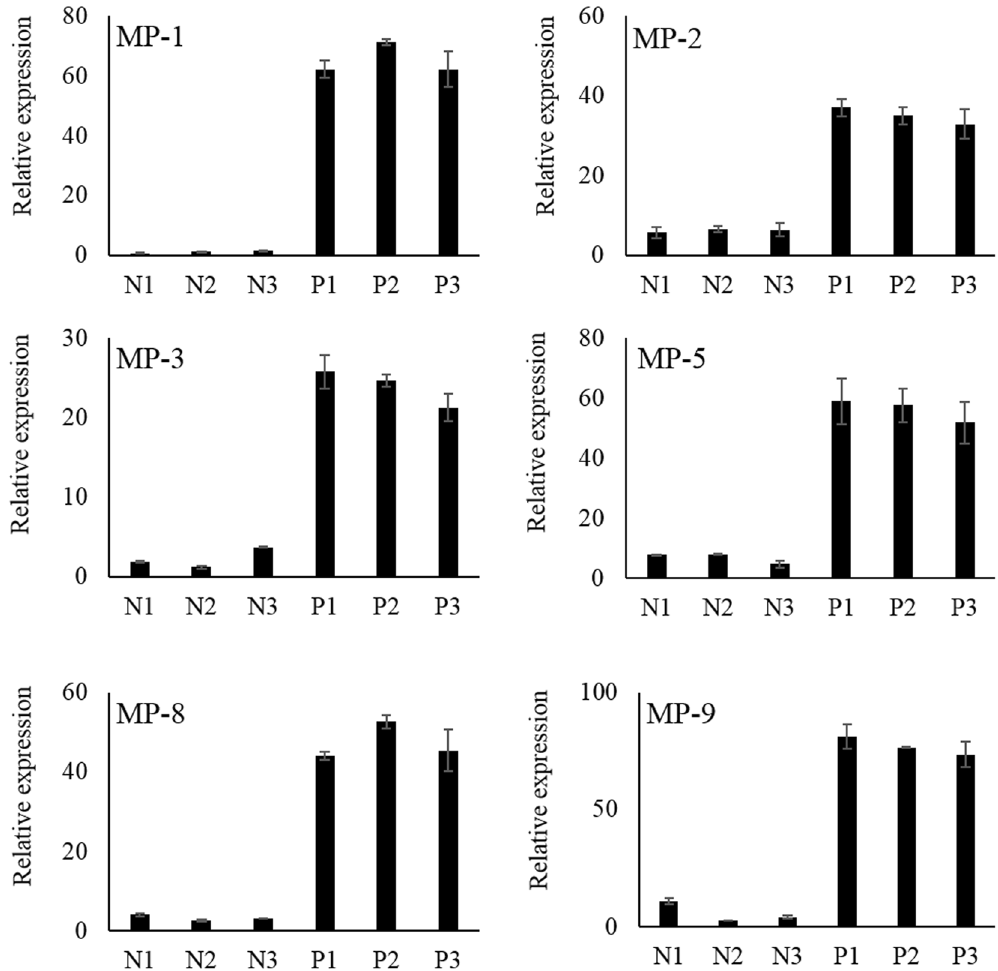
Figure 2. Results of reverse validation of obtained MP-aptamers via